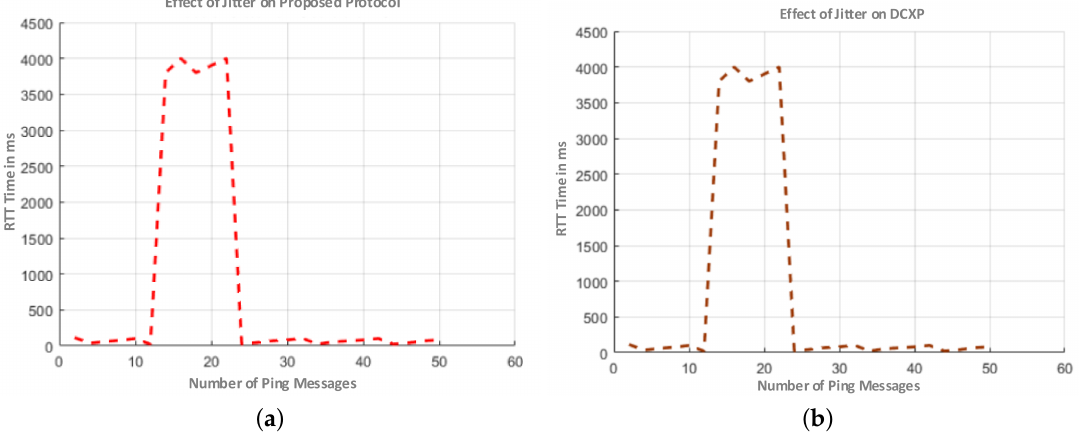
Figure 10. Effect Of Jitter on Proposed Protocol and DCXP. ( a ) Proposed Protocol; ( b )